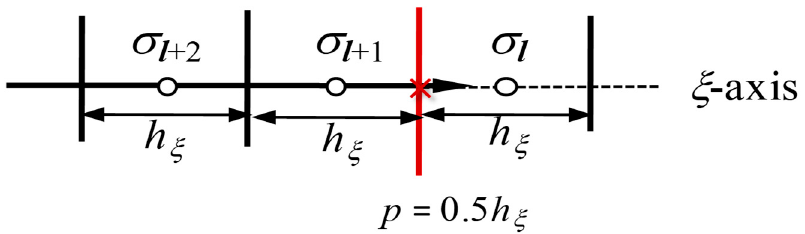
Figure 5. Illustration of symmetry boundary condition.